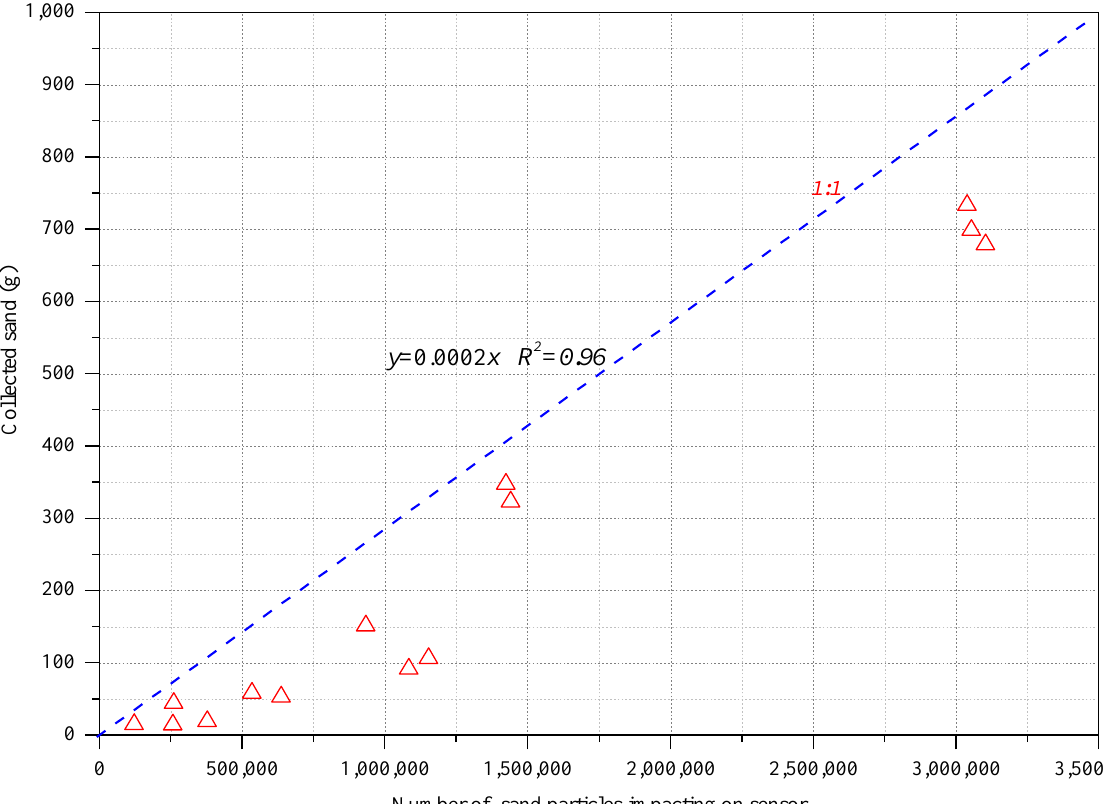
Figure 5. Correlation between the total impact particle number and total sediment concentration.